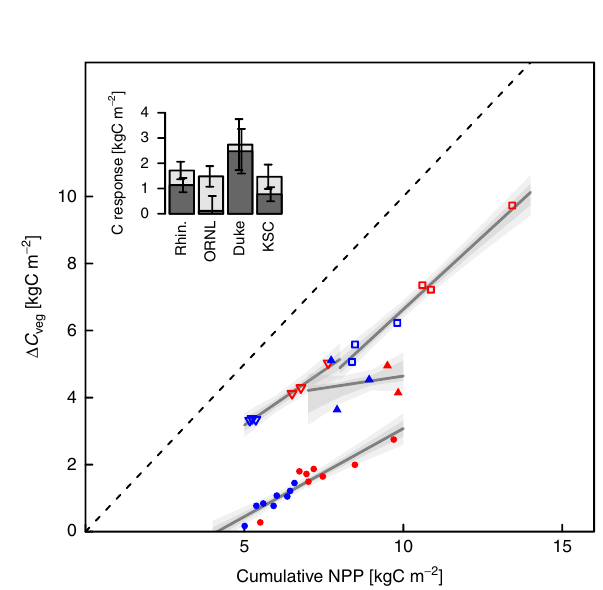
Fig. 2 The relationship between forest biomass increment ( Δ C veg ; kgCm − 2 ) and cumulative NPP (cNPP; kgC m − 2 ) over the duration of the experiments. Each point represents an individual sample plot. Ambient plots shown in blue and elevated in red; open triangles, Rhinelander; fi lled triangles ORNL; open squares, Duke; & fi lled circles KSC. Note the generally large within- site, within-treatment variability in cNPP. Dark grey lines represent the regression from the best mixed-model (Table 2, Model 3), grey polygons represent the site-speci fi c SEM con fi dence interval (CI), and the lighter grey polygons represent the 95% CI. Inset: CO 2 stimulation of cumulative NPP ± SEM (light grey bars) and forest biomass increment ± SEM (dark grey bars) over the duration of the